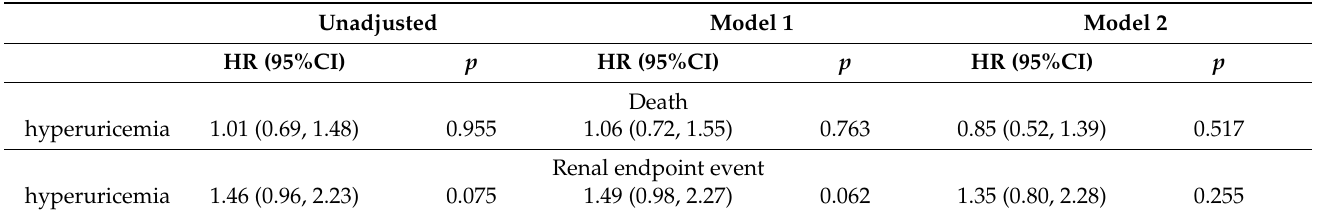
Table 3. Hyperuricemia as a risk factor for clinical outcomes, as assessed by Cox regression models. Unadjusted